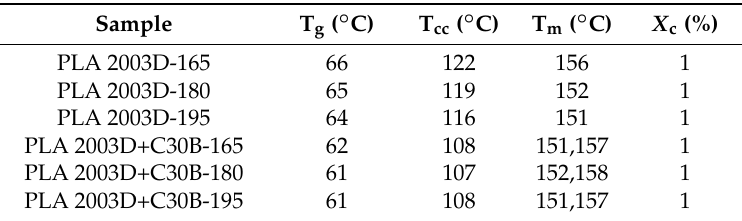
Table 9. Thermal temperatures, enthalpies and degree of crystallinity of PLA 2003D and PLA 2003D+C30B printed specimens (first